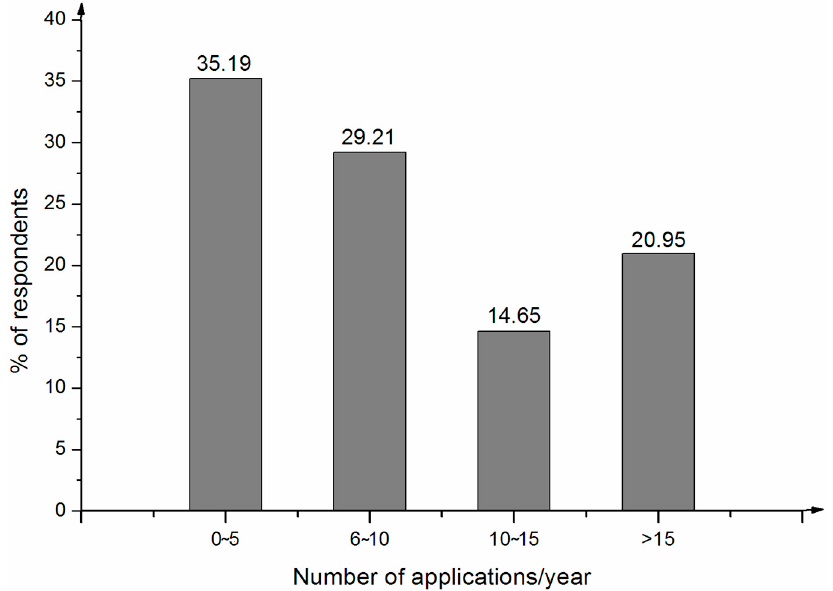
Figure 2. Number of pesticide applications.